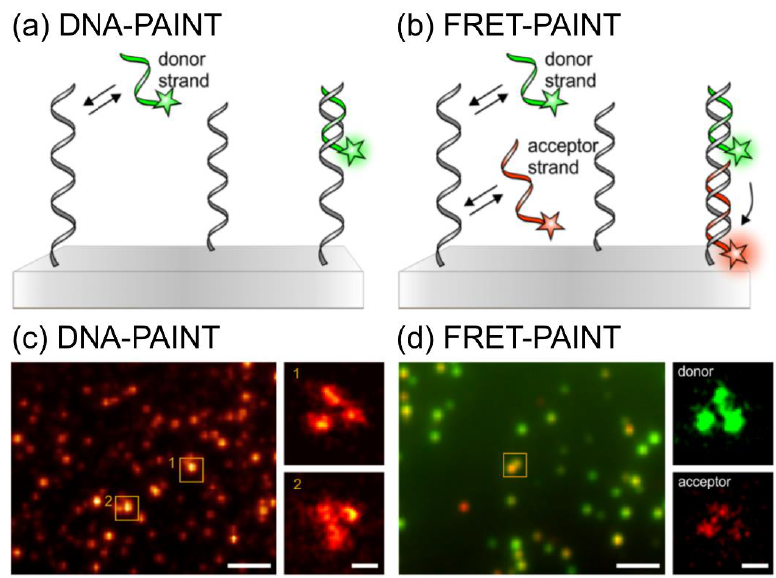
Figure 9. Principle of DNA-PAINT and FRET-PAINT. ( a ) Schematic illustration of DNA-PAINT based on a DNA origami with a donor strand (green highlighted strand) and a docking site (gray strand). ( b ) Illustration of FRET-PAINT with an additional acceptor strand (red highlighted strand). ( c ) DNA-PAINT-based DNA origami image labeled with docking sites (left, scale bar: 2 µm) with regions of interest of single-DNA origami (right, scale bar: 50 nm), observed at 15,000 frames with the calculation of standard deviation. ( d ) Permanent complementary binding of the donor (green, nine nucleotides) and acceptor (red, 10 nucleotides) strands with the docking site of DNA origami images was obtained by FRET-PAINT (left, scale bar: 2 µm). Because of the excitation of the donor strand, the acceptor emission gives FRET-PAINT signal of the binding of both strands with their target sites. SR images are created with the localization of single dyes (right, scale bar: 50 nm). The images were reproduced with permission from Deußner-Helfmann et al., published by American Chemical Society, 2018